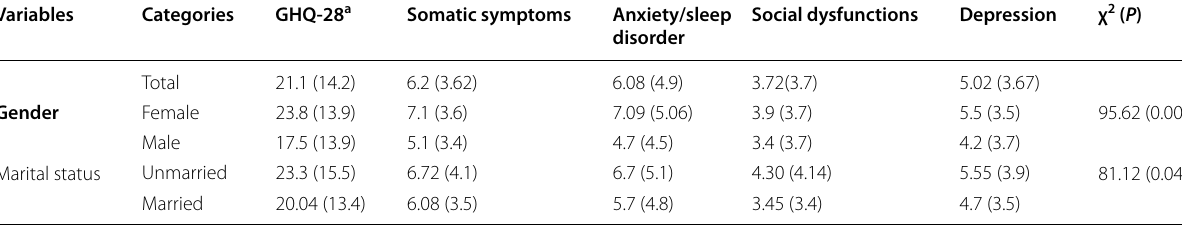
a General Health Questionnaire